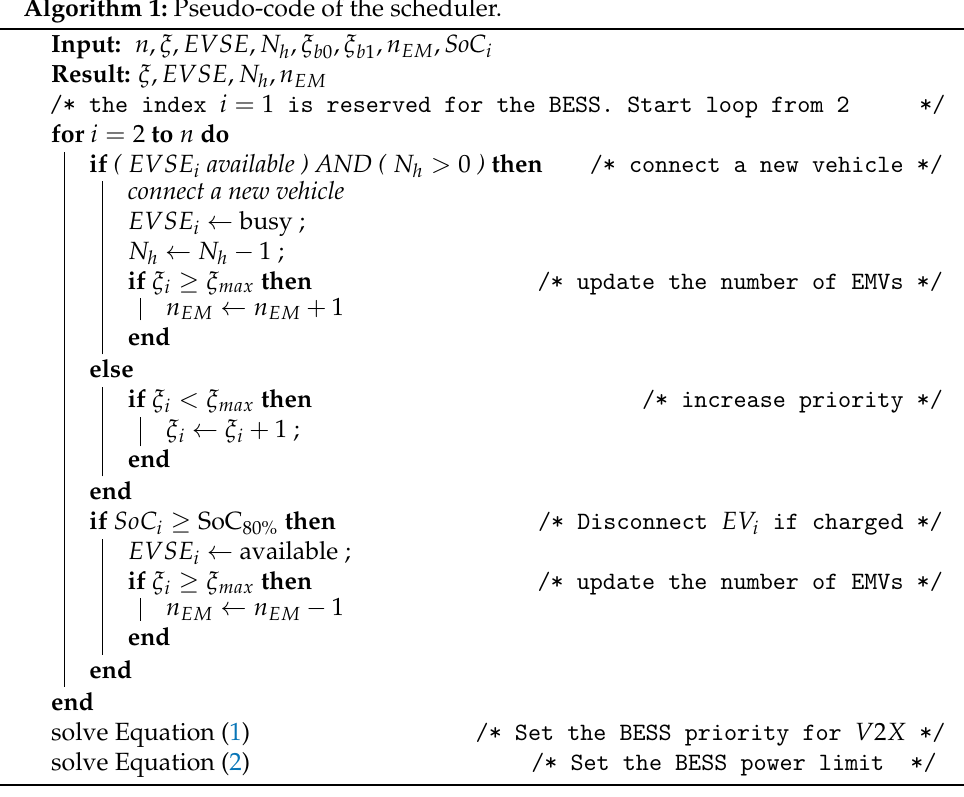
Algorithm 1: Pseudo-code of the scheduler.